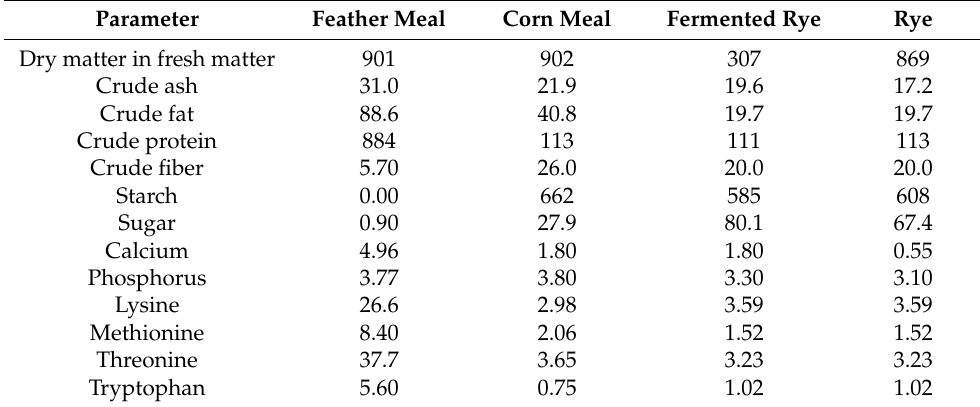
Table 2. Chemical composition (in g/kg DM) of hydrolyzed feather meal, corn meal, fermented rye and rye used in dog